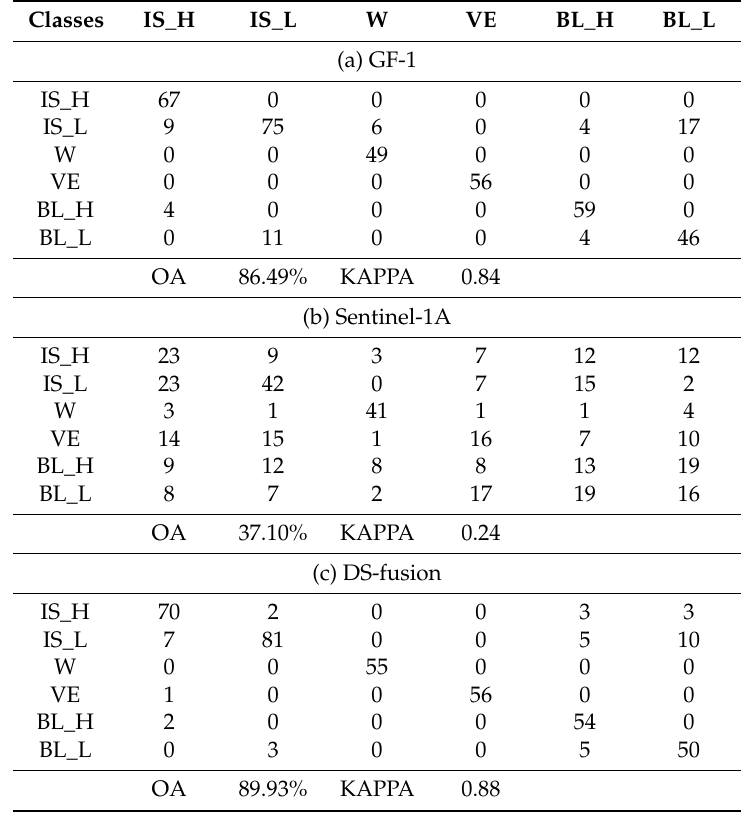
Table 3. The confusion matrix and accuracy assessment for land cover classification by using the GF-1 image/Sentinel-1A image/fusing the GF-1 and Sentinel-1A image.